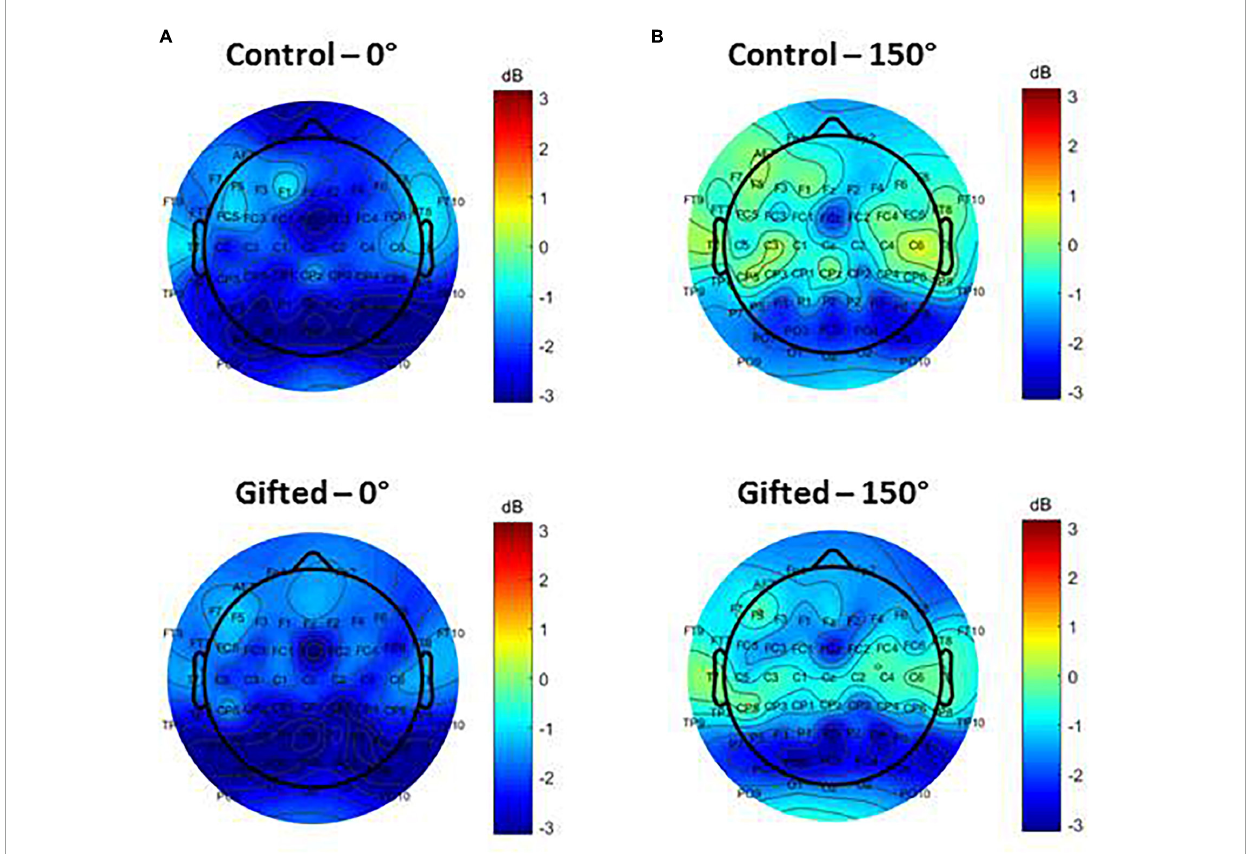
FIGURE2 Electroencephalographic (EEG) scalp topography of alpha ERSP during the mental rotation interval (963–1183 ms). The maps are based on average alpha ERSP of the participants during trials with 0 ◦ (A) and 150 ◦ (B) of disparity between the template and target stimuli. Topographic maps of controls are on the top of the gifted group on the bottom. Values correspond to the mental rotation interval (defined by Anomal et al., 2020) and are color-coded according to ERSP’s amplitude in µ V.